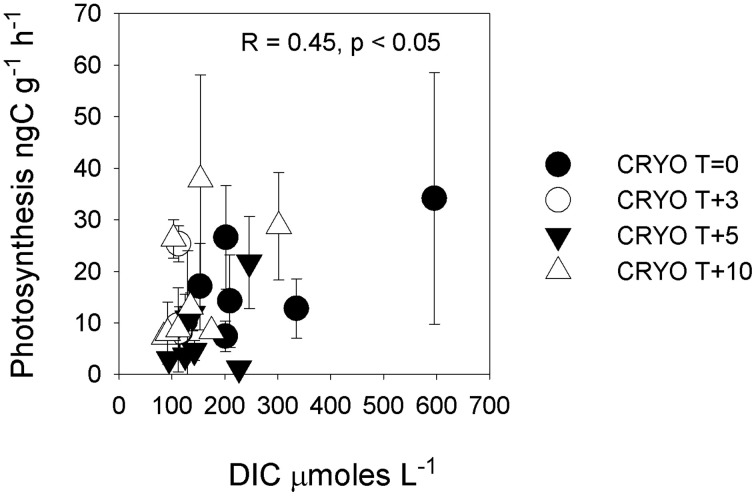
Rate of photosynthesis in cryoconite vs. dissolved inorganic carbon (DIC). Statistics refer to Pearson correlation. Note that the significance of the relationship disappears when the highest DIC sample is removed.